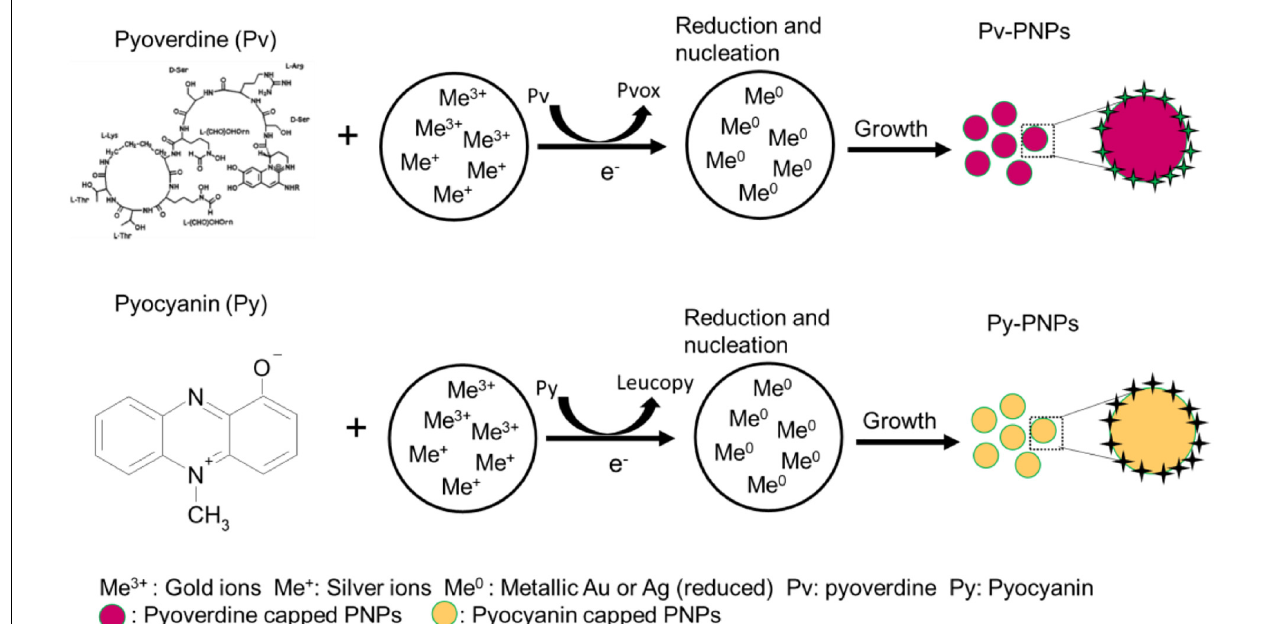
FIGURE 7 | Schematics illustrating the pyoverdine and pyocyanin mediated reduction of gold and silver ions and subsequent formation of respective nanoparticles (Pv-PNPs and